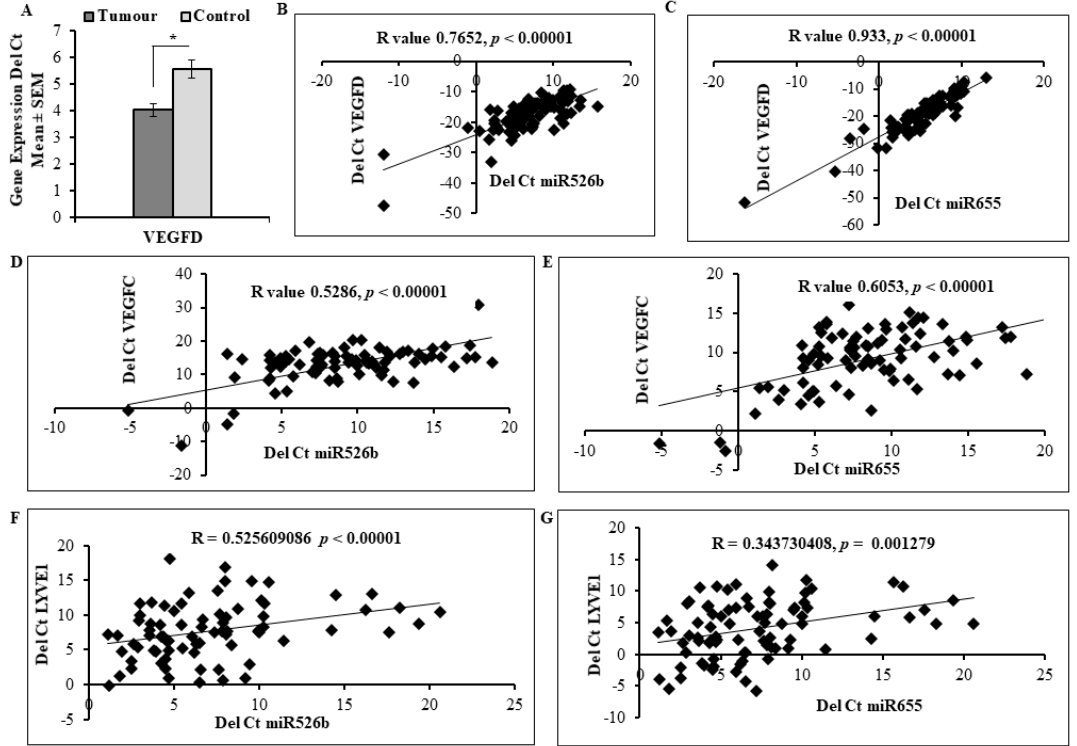
Figure 7. miR526b and miR655 expression is positively correlated with lymphangiogenesis markers in human breast tumours. ( A ) qRT-PCR analysis of VEGFD mRNA expression in control (adjacent non-tumour) and tumoural tissues. Data are represented as a mean ± SD. (*) indicates significant differences ( p < 0.05). ( B , C ) miR526b and miR655 expression is positively correlated with the VEGFD in primary breast cancer samples; Pearson’s coefficient indicates a very strong positive correlation. ( D , E ) miR526b and miR655 expression level is positively correlated with another lymphangiogenesis marker VEGFC in primary breast cancer samples. Pearson’s coefficient suggests a positive correlation between the two variables. ( F , G ) Finally, LYVE1 mRNA expression is positively correlated with miR526b and miR655 expression in tumour samples. Pearson’s coefficient suggests a moderate correlation between the two variables. Table 2. Percentage of samples that show higher expression of the two miRNAs (negative delta Ct values) in various stages of tumour and hormonal receptors status. We conducted a Z score analysis by comparing proportions. The analysis shows the proportion of miR526b high expression samples were more in tumor grade II and III; however, this was not significant. For miR655, there was no difference in the distribution of high expression across tumor grades recorded. A higher proportion of samples showing high miR526b and miR655 expression can be seen in ER positive samples; however, the difference is not statistically significant, although larger sample size may increase significance. Other receptor status also shows no significant difference between presence or absence of individual receptor.